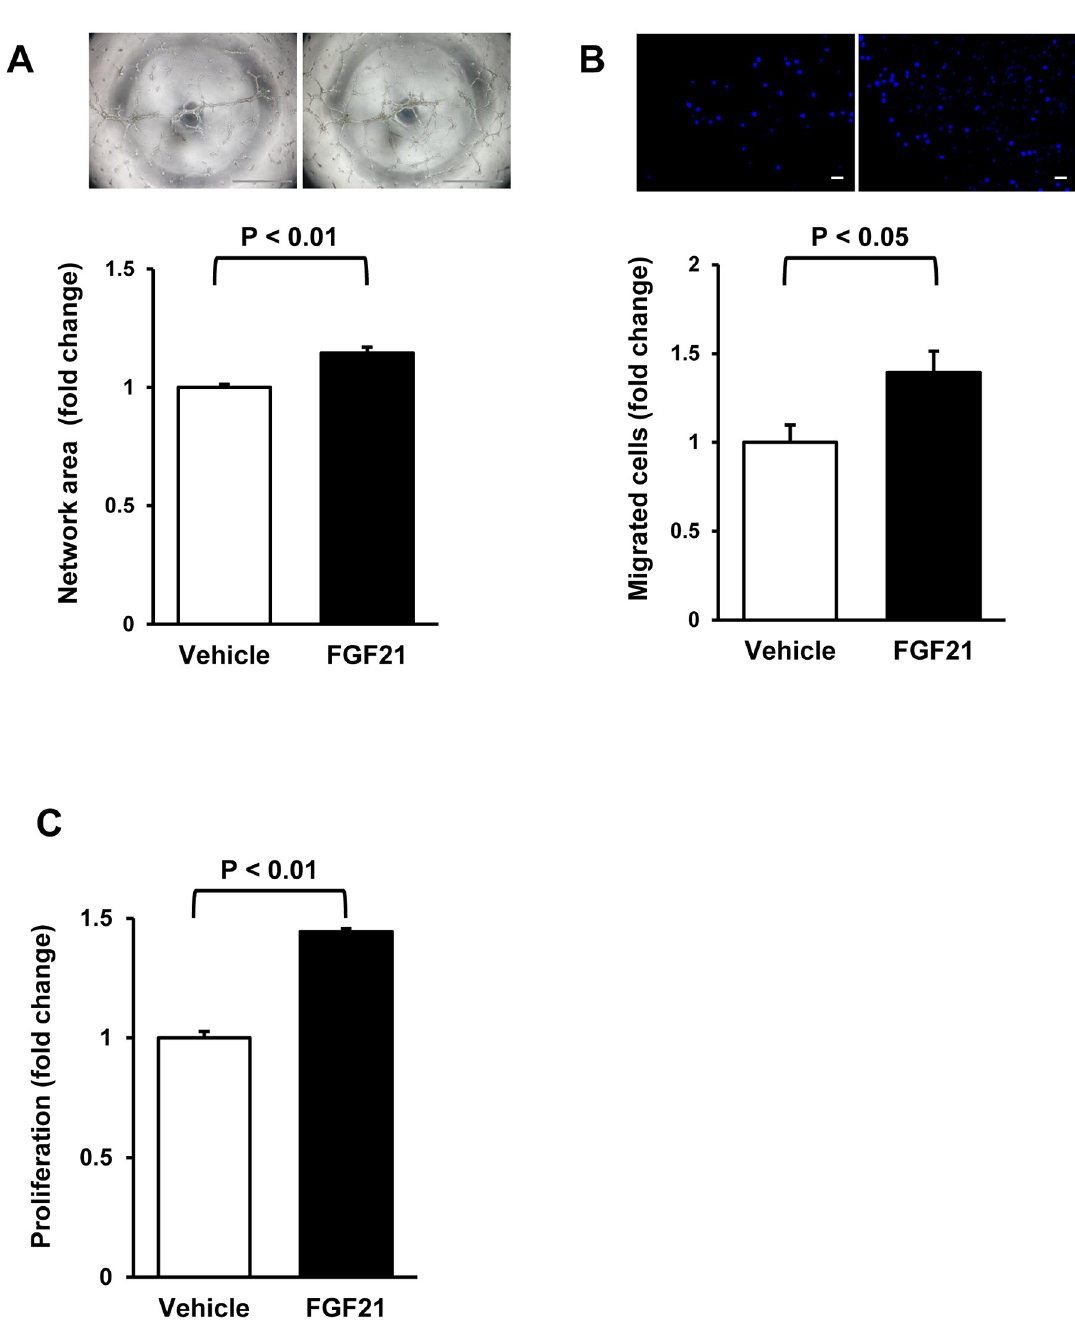
Fig 5. FGF21 promotes endothelial cell function. A . Quantitative analysis of network area at 16 h after treatment with FGF21 protein (10 nM) or vehicle. Upper panels show representative photos of network formation of HUVECs. N = 5 in each group. Scale bars show 1 mm. B . The number of migrated HUVECs at 8 h after treatment with FGF21 (10 nM) or vehicle. Upper panels show representative photos of DAPI staining of migrated HUVECs. N = 6 in each group. Scale bars show 100 μ m. C . Proliferative activity of HUVECs at 24 h after treatment with FGF21 (10 nM) or vehicle. N = 10 in each